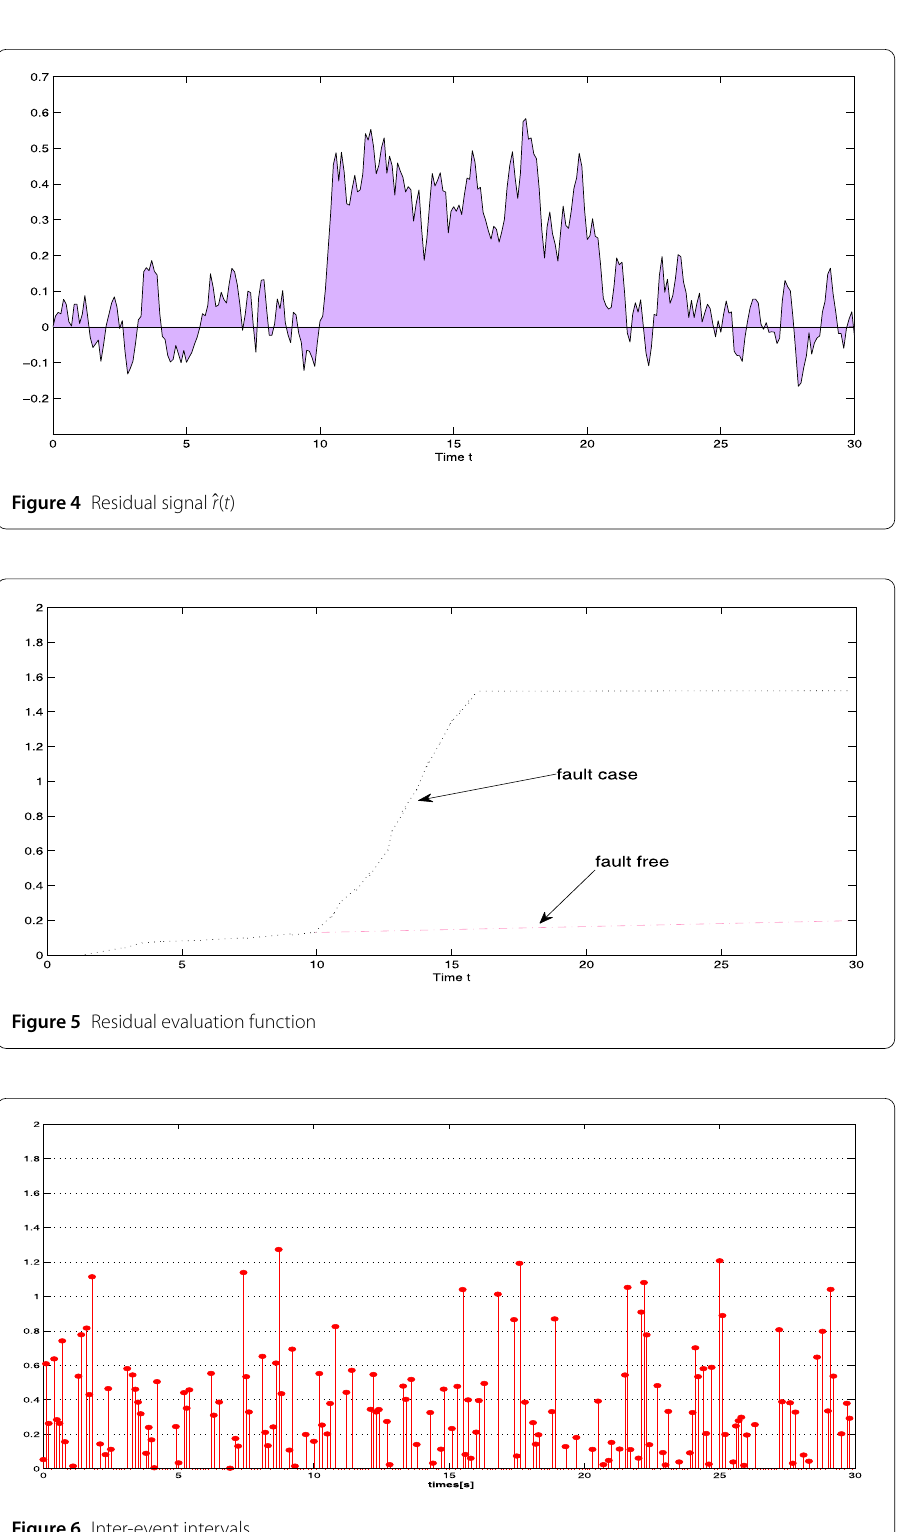
Figure 6 Inter-event